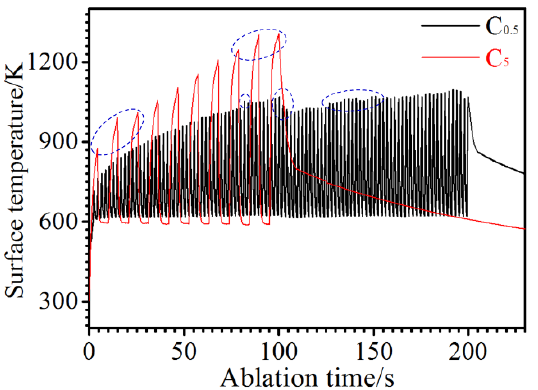
Figure 8. Surface temperatures of the C/C-SiC-ZrC samples during